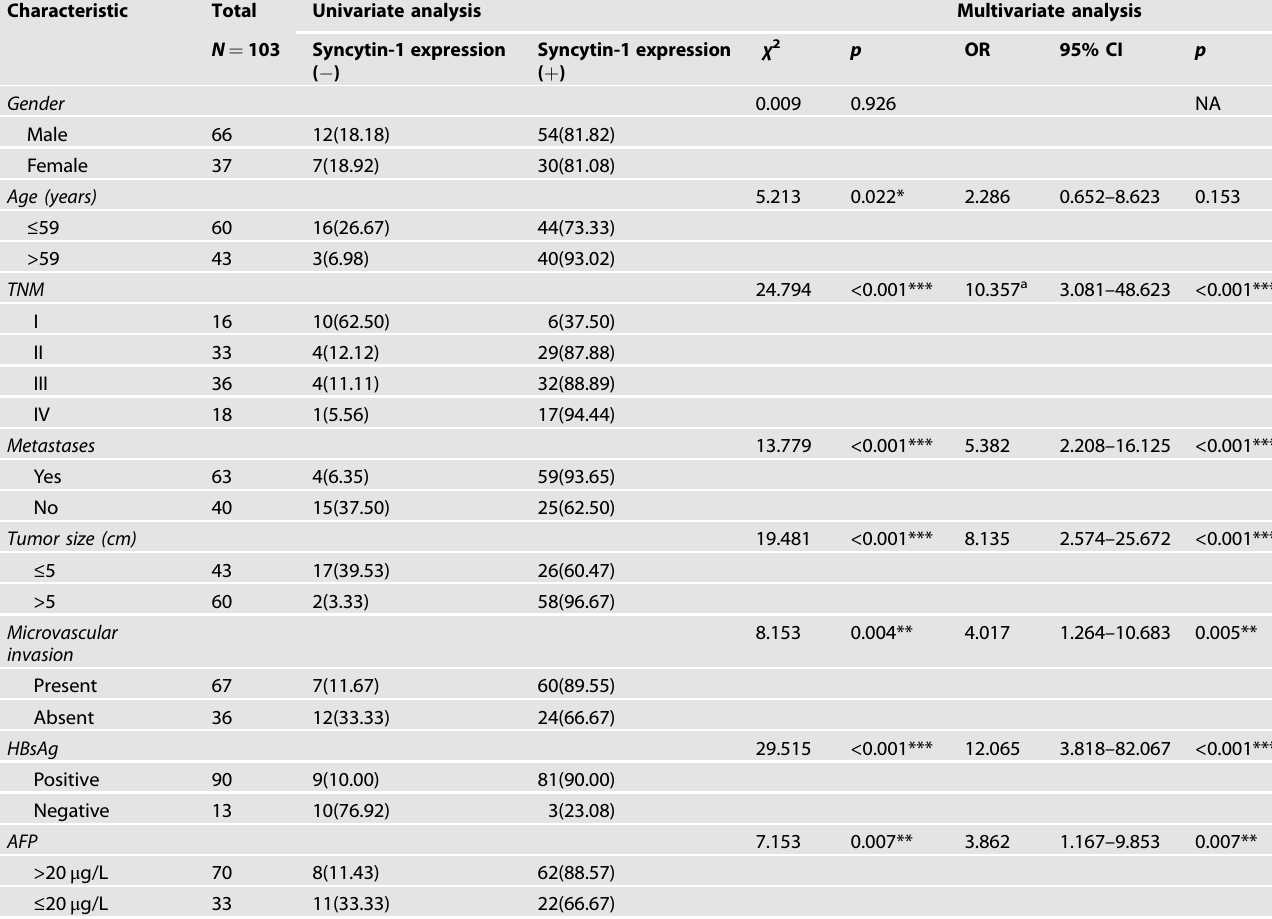
Table 1. Univariate and multivariate analysis Syncytin-1 overexpression and various risk factors in 103 HCC patients. Characteristic